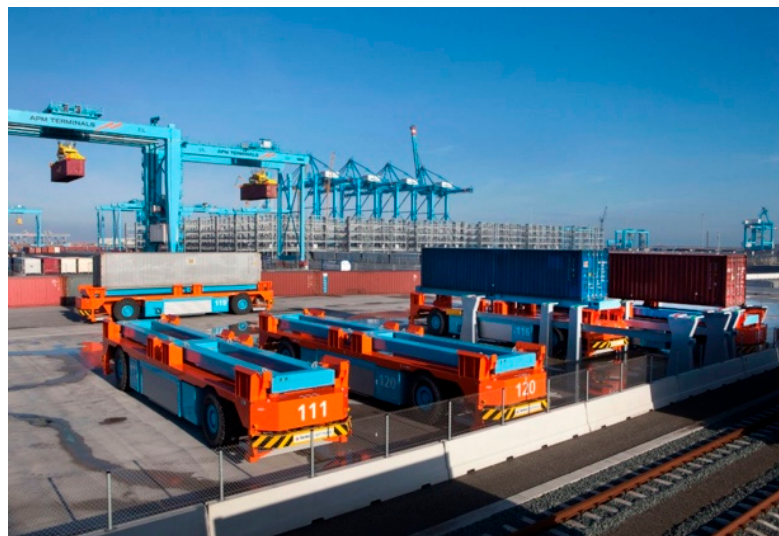
Figure 6. Electric automated guided vehicles (AGVs) at APM Terminal. Reproduced with permission from [15].